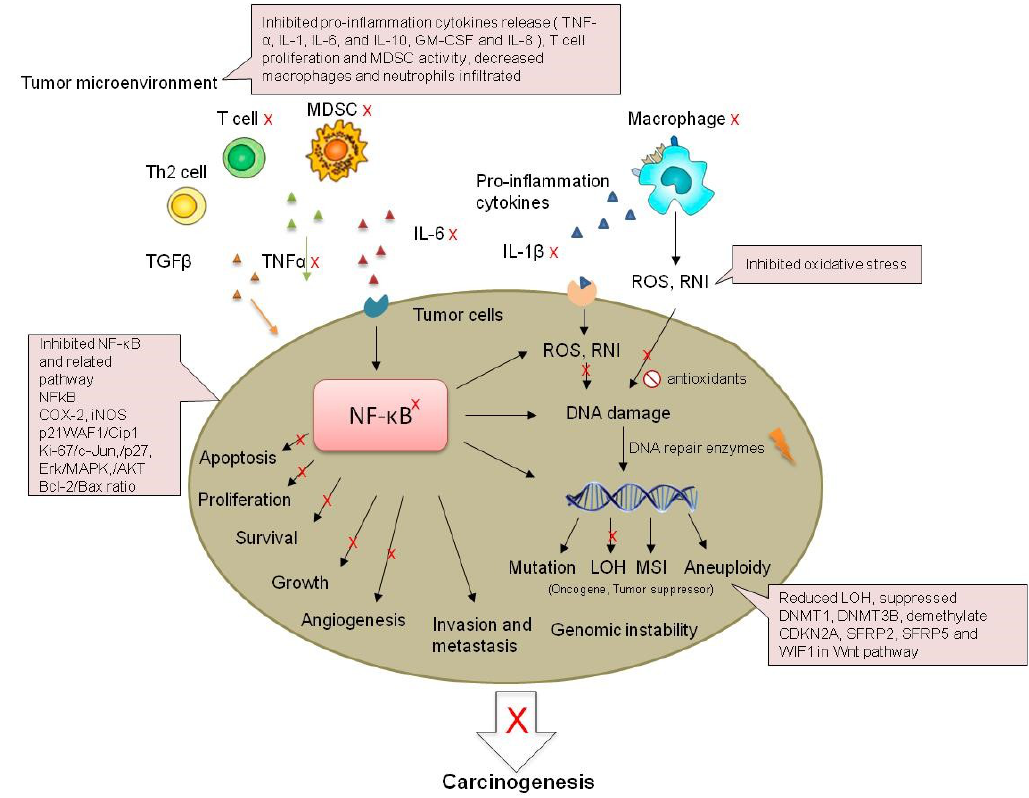
Figure 3. Possible mechanisms of the inhibition of IBD-related CRC by strawberry and black raspberry. MDSC: myeloid-derived suppressor cells; RNI: reactive nitrogen intermediates; LOH: Loss of heterozygosity; MSI: microsatellite instability.